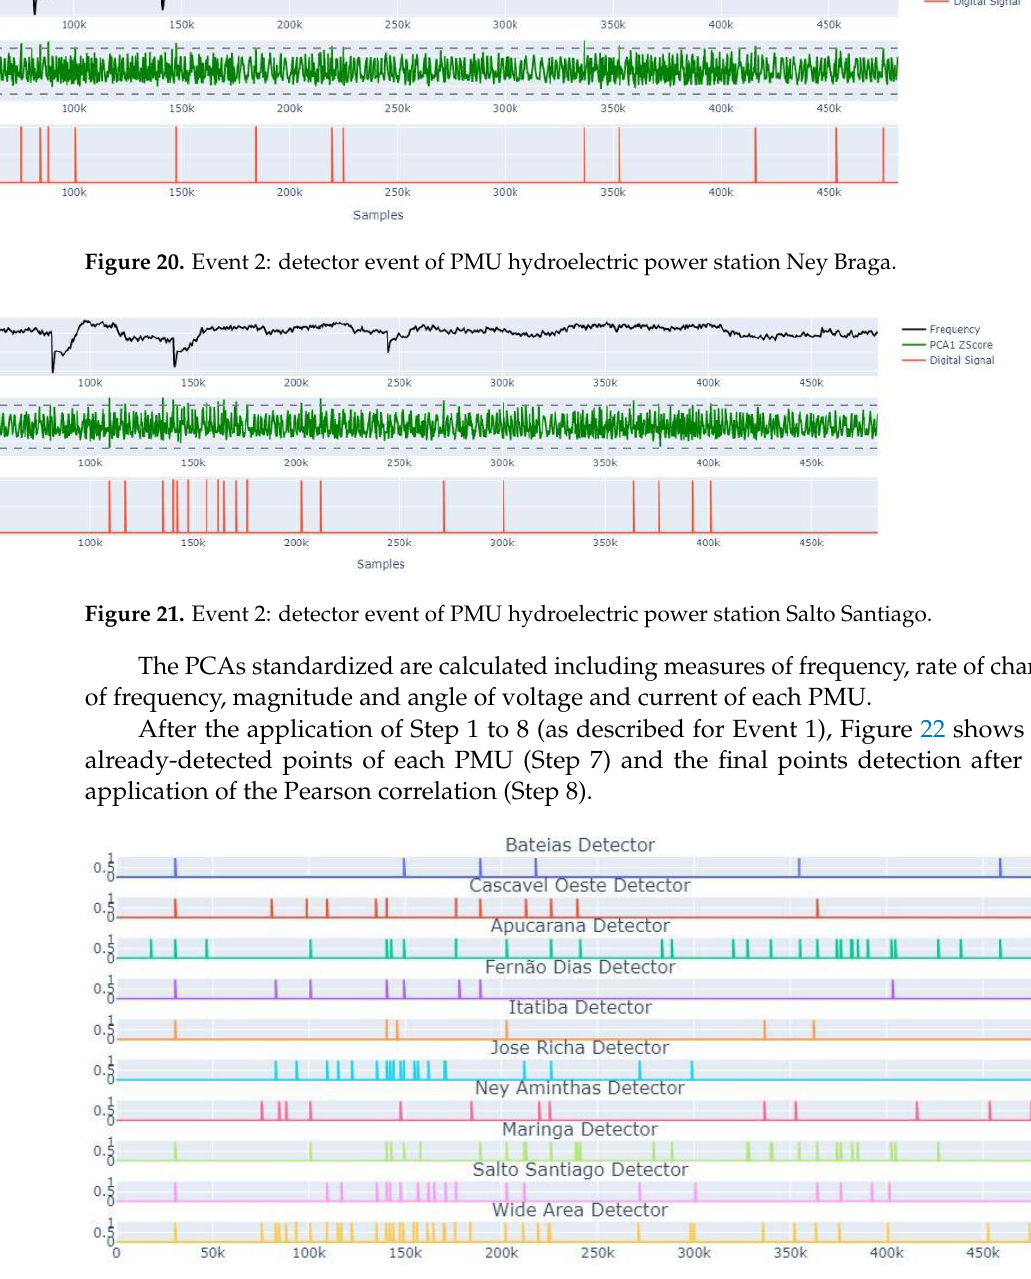
Figure 22. Event 2: PMUs detectors and final detector.